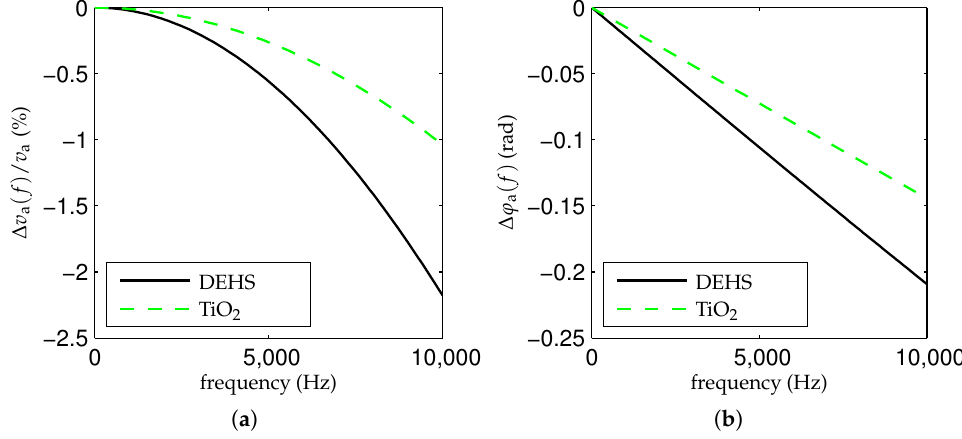
Figure 8. Deviation of ( a ) the amplitude and ( b ) the phase of a cosinusoidal excitation due to the particle-following behavior of the particles listed in Table 1.